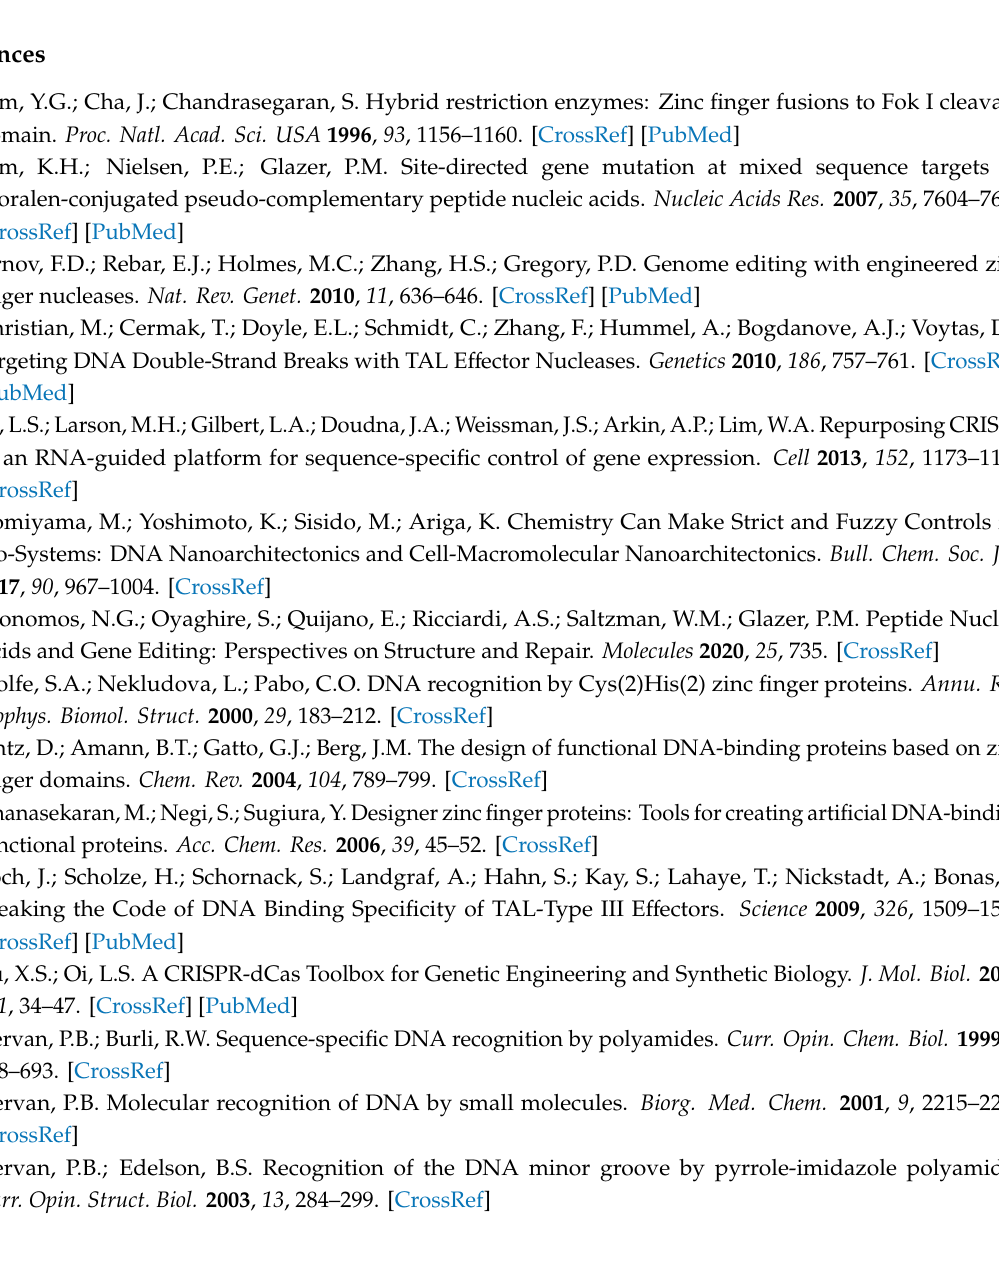
Figure S1: chemical structures of 2,6-diaminopurine (D) and 2-thouracil (U), Figure S2: HPLC charts of purified PNAs, Figure S3: MALDI-TOF MS spectra of purified